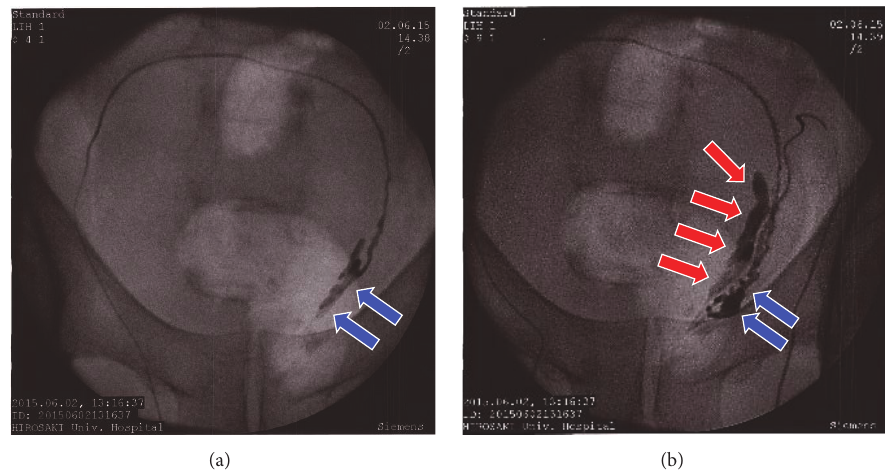
Figure 2: Image of vasography. (a) Right vasography; (b) left vasography. Blue arrow: right seminal vesicle. Red arrow: left seminal vesicle. Vasography showed that the right seminal vesicle was largely shifted to the left side but shape of right seminal vesicle was kept.